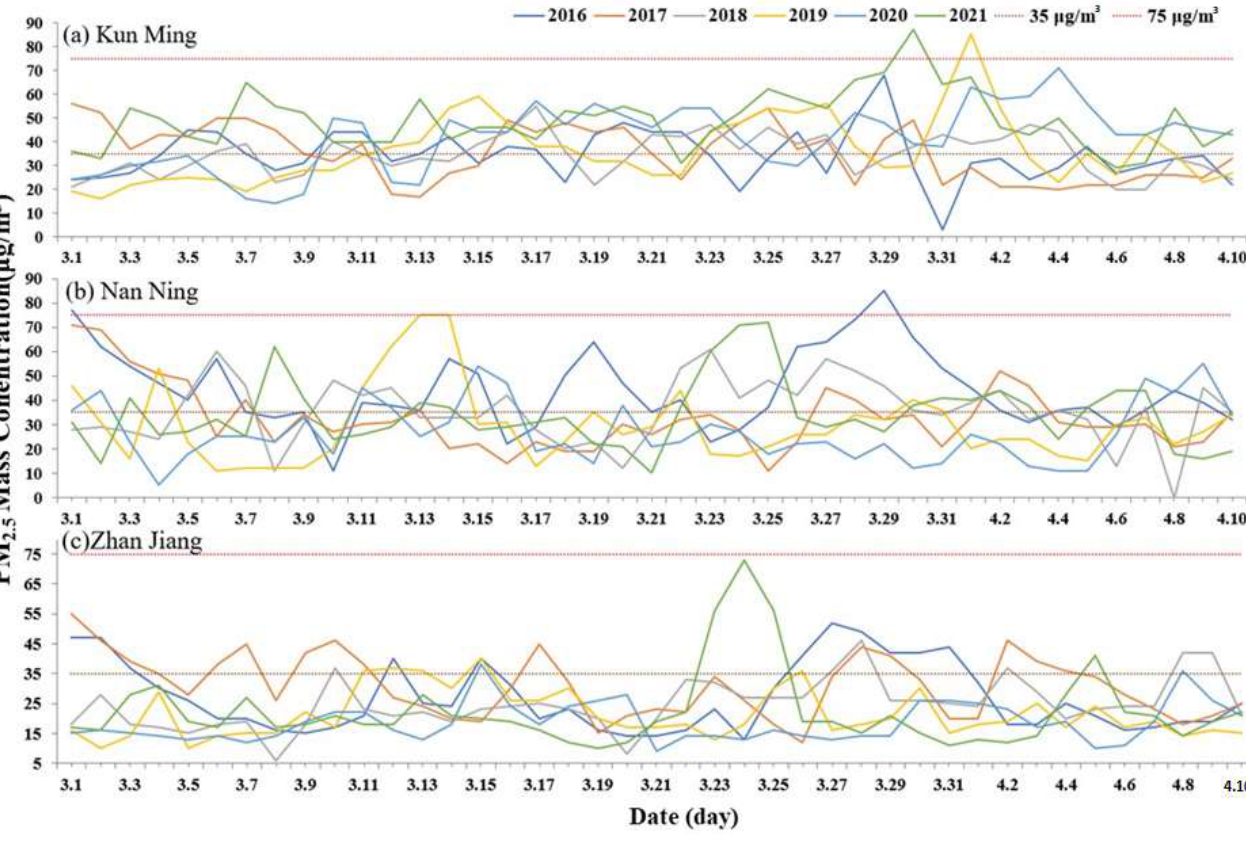
Figure 8. Changes in PM 2.5 in ( a ) Kunming, ( b ) Nanning and ( c ) Zhanjiang. (The PM 2.5 concentration data is the result of averaging the hourly data from the main environmental protection station on the same day).